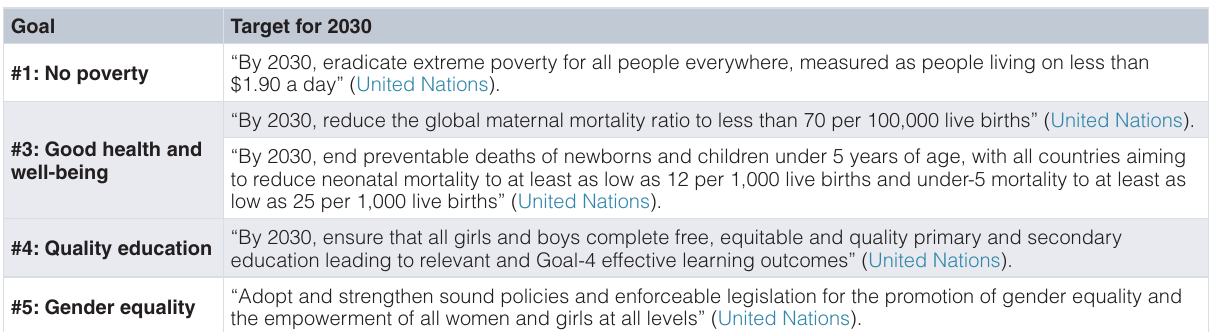
Table 1. Relevant Sustainable Development Goals for evaluating potential impact of suppressing malaria among agricultural households in Sub-Saharan Africa. Source: ‘Sustainable Development Goals - 17 Goals to Transform Our World’ (United Nations,